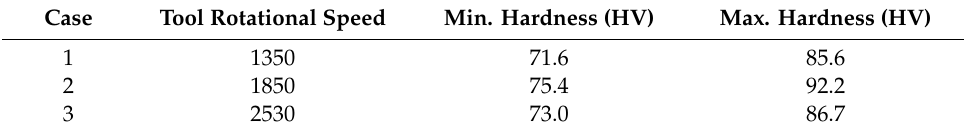
Table 6. Maximum and minimum hardness values for di ff erent experimental